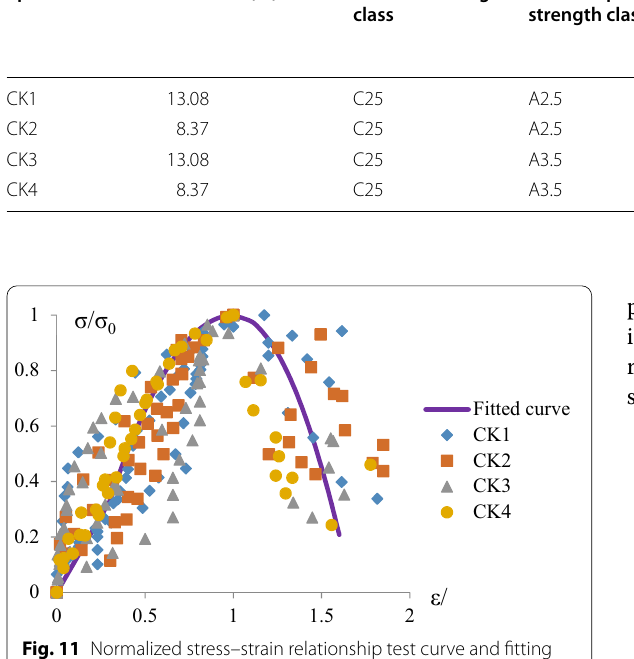
Table 6 Comparison of recommended values with regulatory values (MPa). Specimen